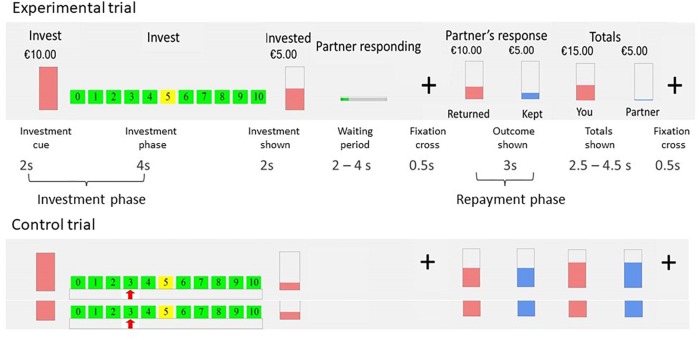
Graphical overview of the trust game. Note: Top row represents the visual stimuli in the game trials; middle row are the separate phases including durations of the trust game; bottom row represents the visual stimuli in the control trials. Taken with permission from Lemmers-Jansen et al. (2017).